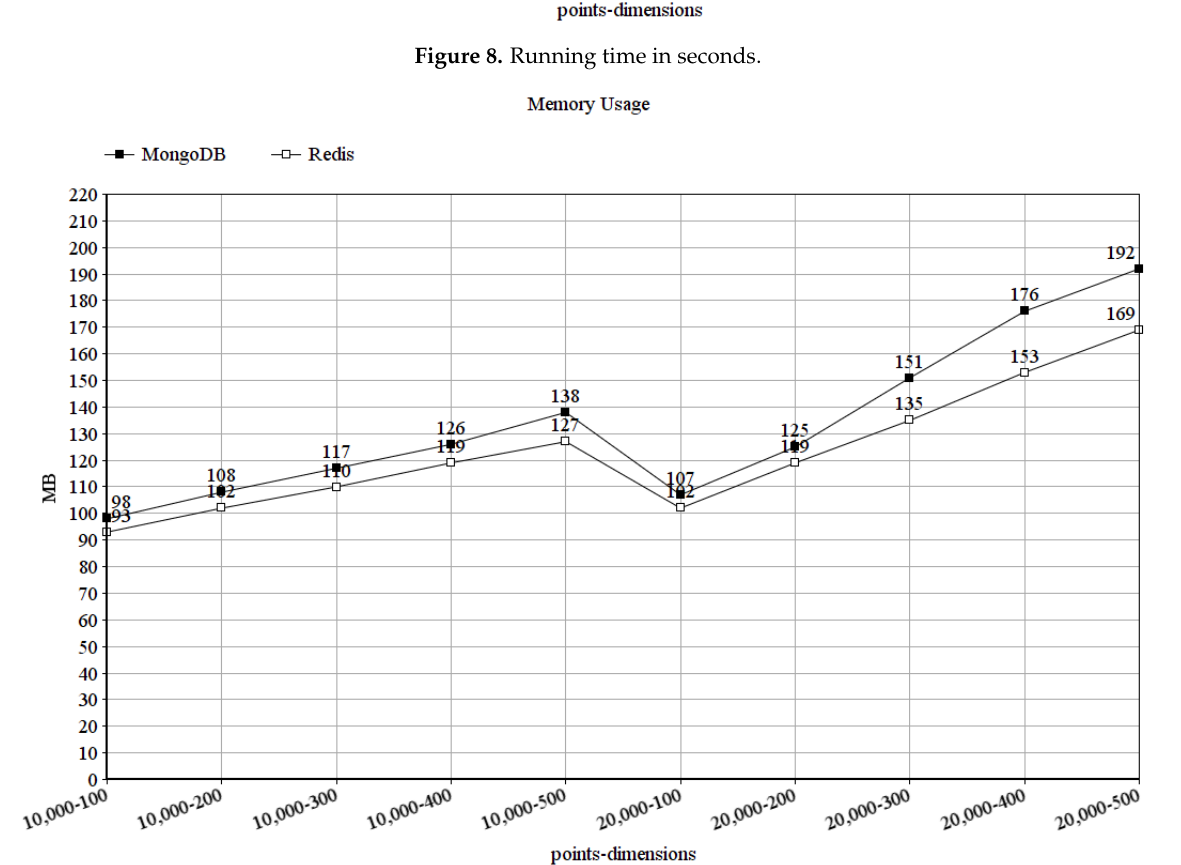
Figure 9. Memory usage in